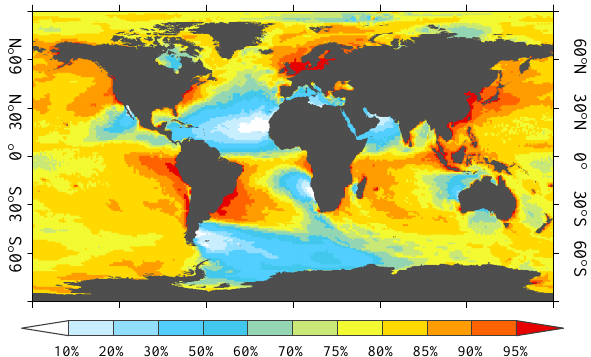
Figure 18. Relative contribution of combustion-related emissions to atmospheric soluble Fe deposition over oceans. Constant Fe sol- ubilities (0.44% for dust, 22.5% for coal fly ash, 79% for oil fly ash and 18% for biomass fly ash) were applied to calculate the de- position of soluble Fe from the deposition of total